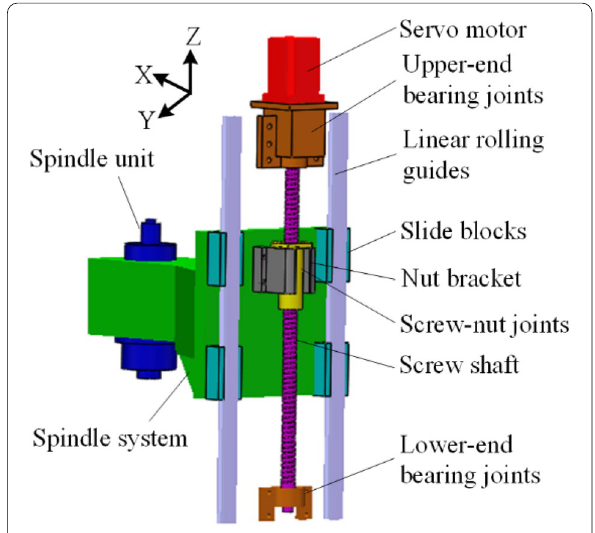
Figure 1 Structure of the vertical ball screw feed